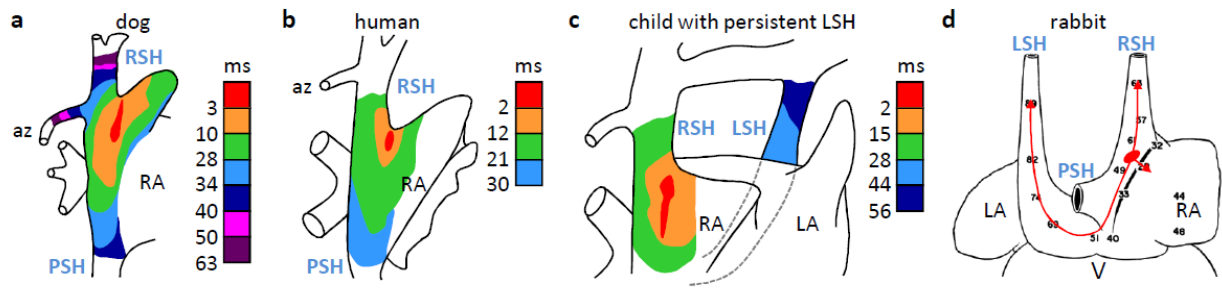
Figure 2. The sinus venosus-derived myocardium is electrically synchronized with the atria in mammals. ( a ) In dog, the extensive sinus myocardium of the right sinus horn (RSH) and the azygos vein (az) is activated in synchrony with the right atrium (RA) (notice that the atrial activation was not mapped in its entirety). ( b ) Sinus myocardium is less extensive in man than in dog, but is activated in synchrony with the right atrium. ( c ) In the case of persistent left sinus horn (congenital malformation), this part of the sinus is also synchronized to the atria. While malformed, the presence of two sinus horns resembles that of basal mammals and the rabbit. ( d ) In rabbit, activation of the sinus horns is synchronized with the atria. Activation spreads far cranially, which indicates extensive myocardial investment in the vessels. Modified from [83] ( a – c ) and [84] ( d ). az, azygos vein; A, atria; LA, left atrium; LSH, left sinus horn; PSH, posterior sinus horn; RSH, right sinus horn; RA, right atrium; V,